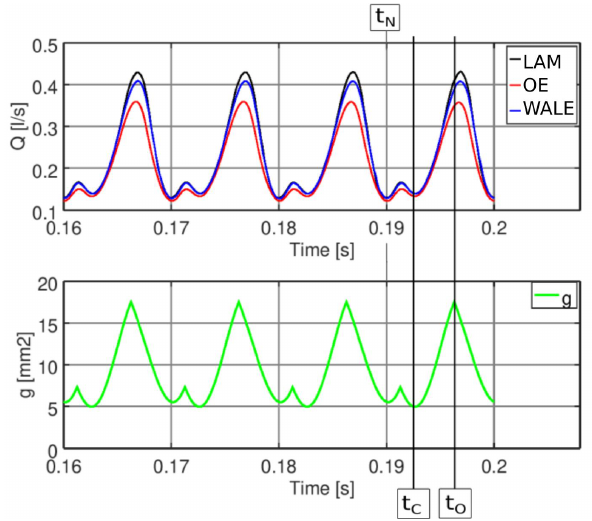
Figure 2. Flow rates during four oscillation cycles and glottal